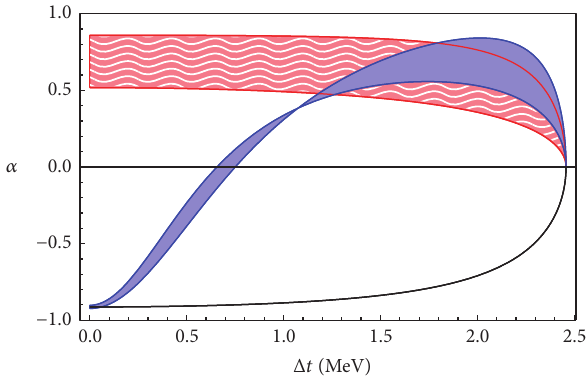
Figure 10: Same as Figure 8 for 136